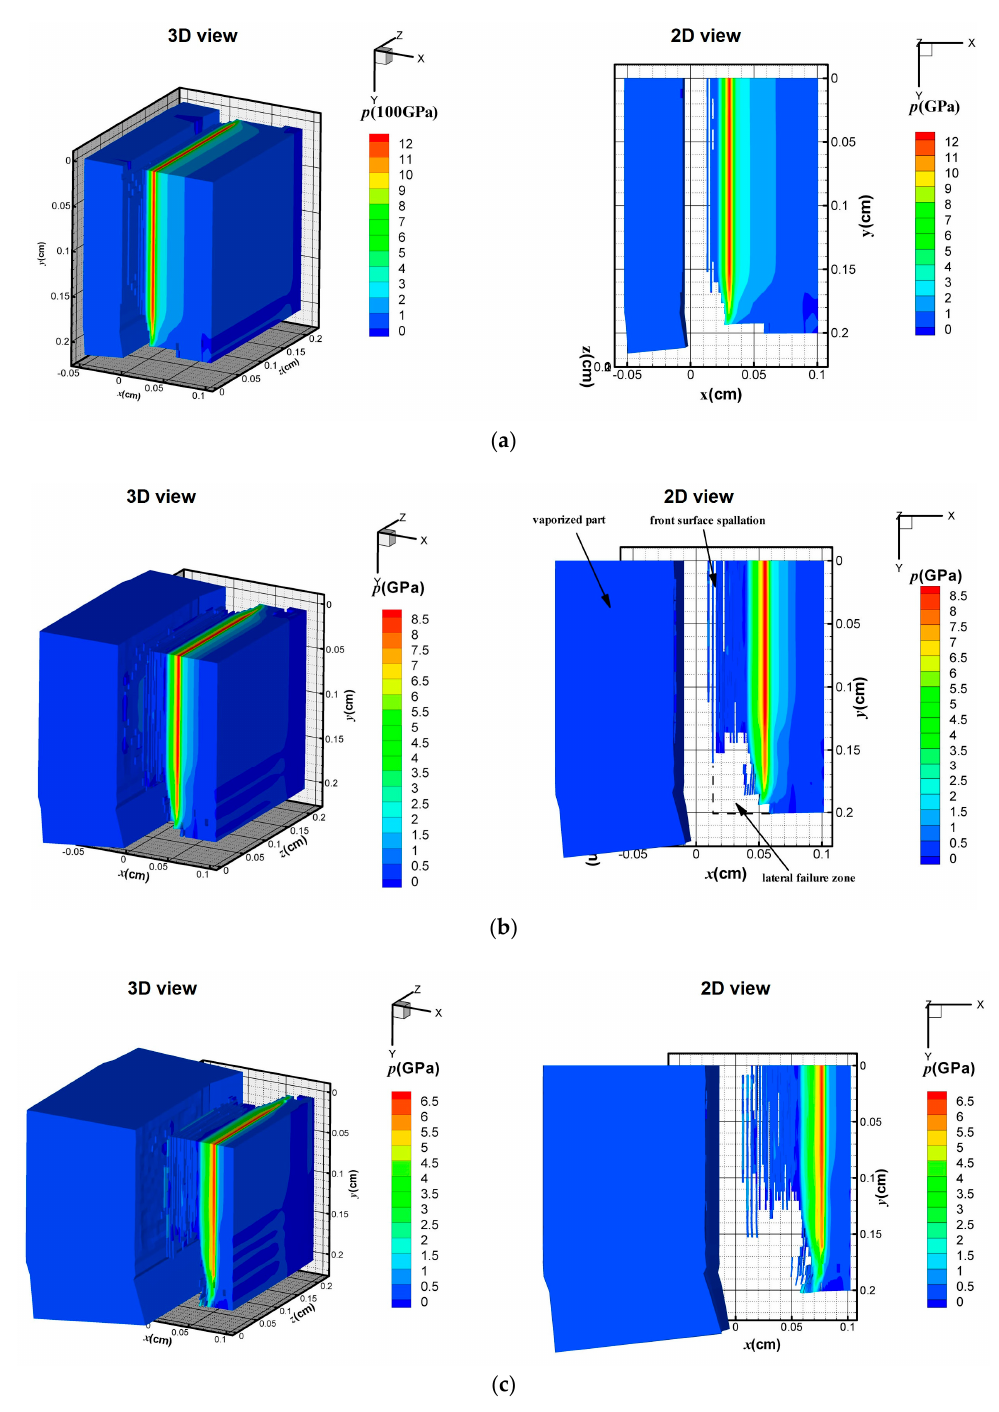
Figure 7. Stress wave under 1 keV X-ray at: ( a ) 0.05 μ s; ( b ) 0.10 μ s; and ( c ) 0.15 μ s.